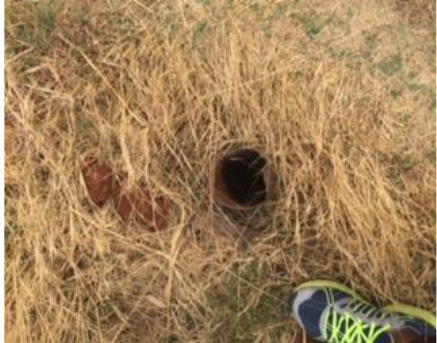
Figure 10. Poorly constructed borehole in the southern landfill site.